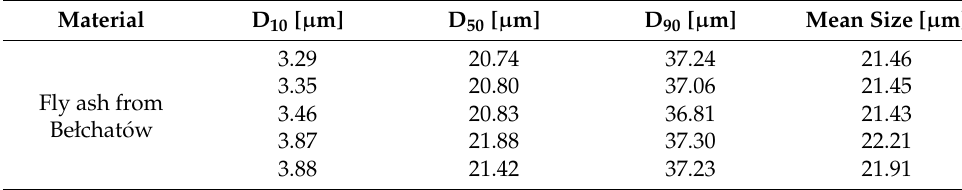
Table 6. Particle size analysis of the Belchat ó w lignite fly